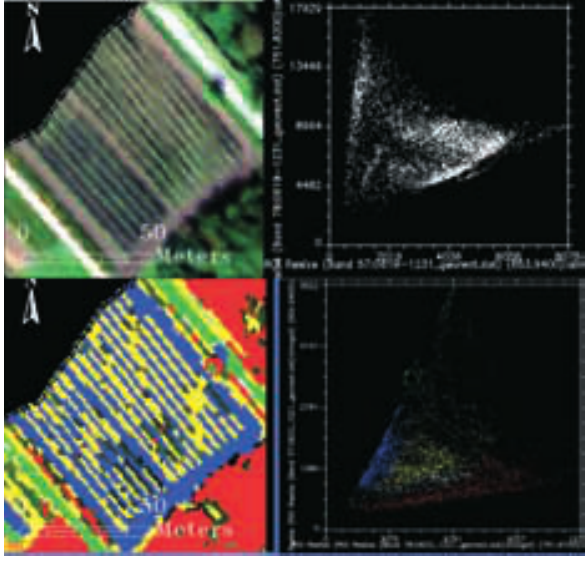
Figure 2. Apple orchard and scatter plot of NIR and RED and their classification